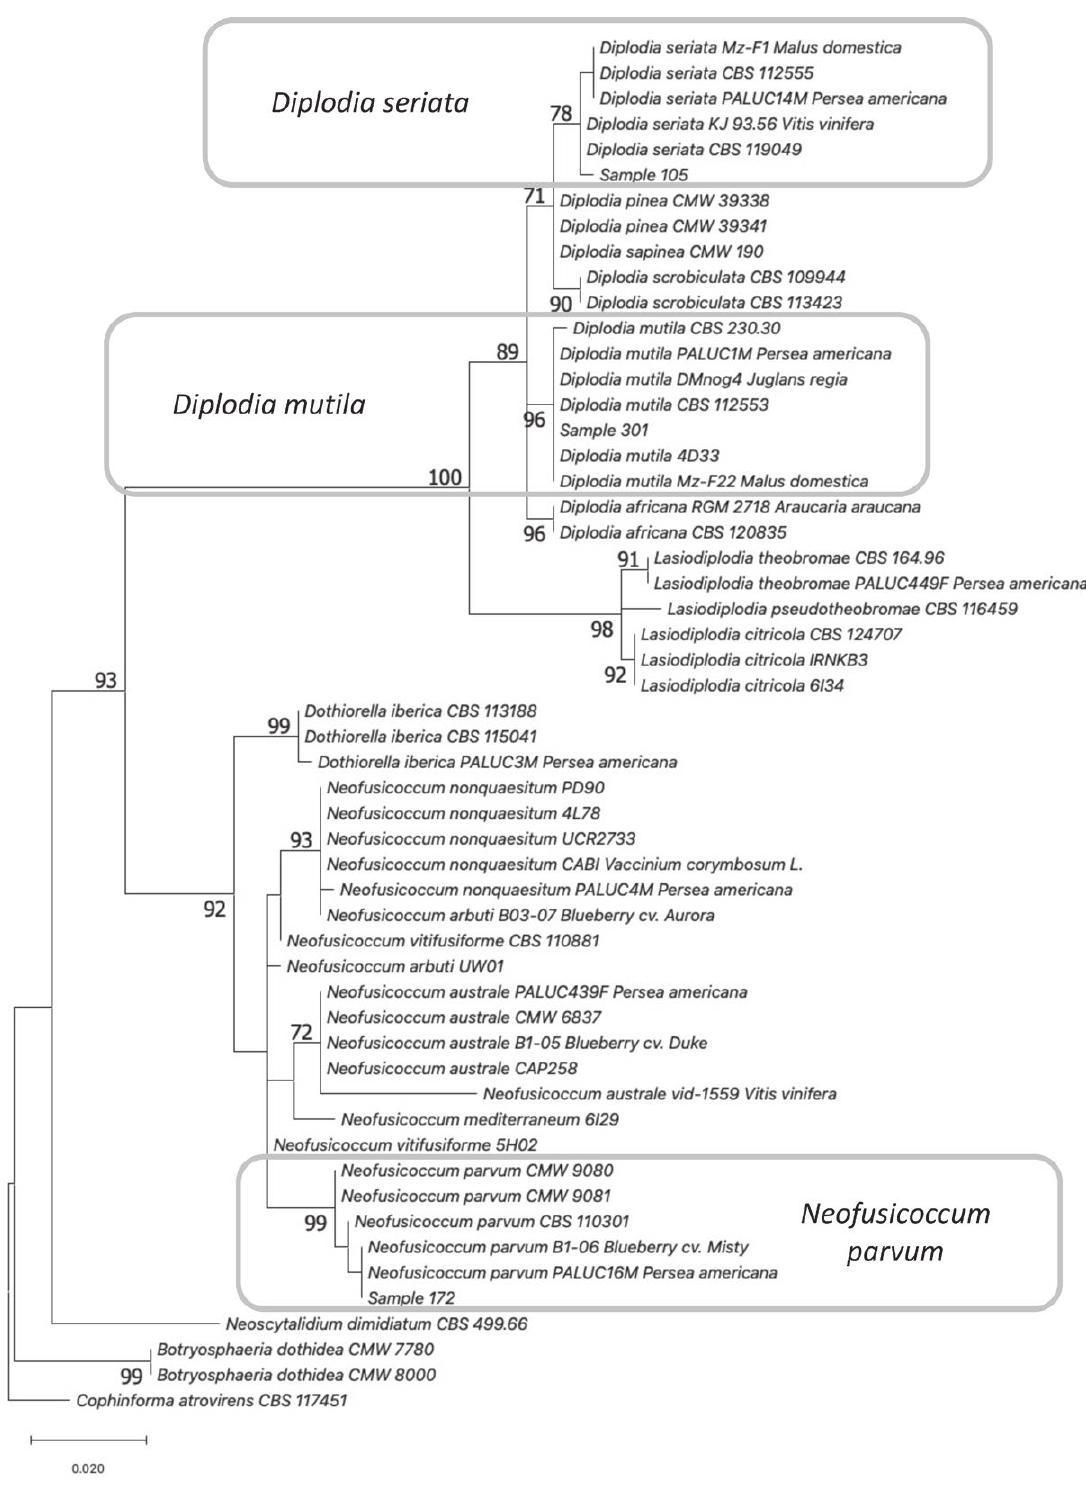
Figure 2. Phylogenetic tree reconstructed by maximum likelihood analysis from the sequences of the nuclear ribosomal internal transcribed spacer. The dataset included three novel Botryosphaeriaceae taxa isolated from three walnut orchards in Chile and 51 GenBank sequences of Botryosphaeriaceae that included reference sequences as well as sequences of previously reported Chilean walnut pathogens. The tree is drawn to scale, with branch lengths measured in the number of substitutions per site. Numbers on branches are bootstrap support